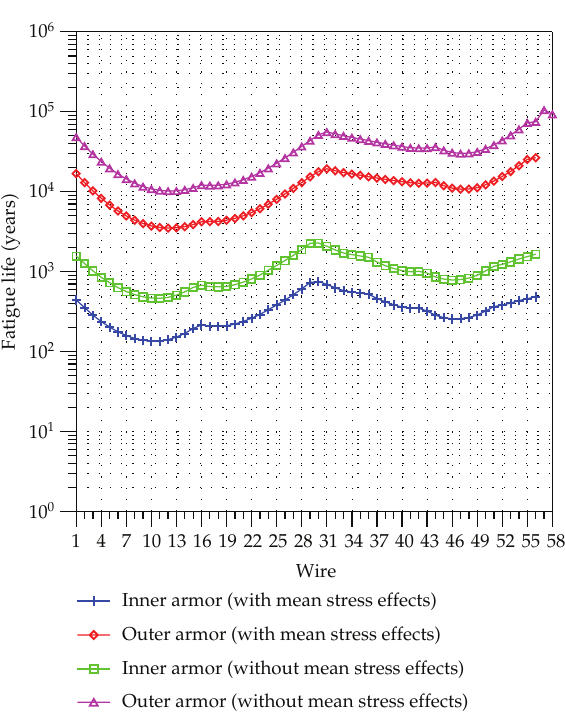
Figure 14: Fatigue life in the wires of the critical cross-section: e ff ect of mean